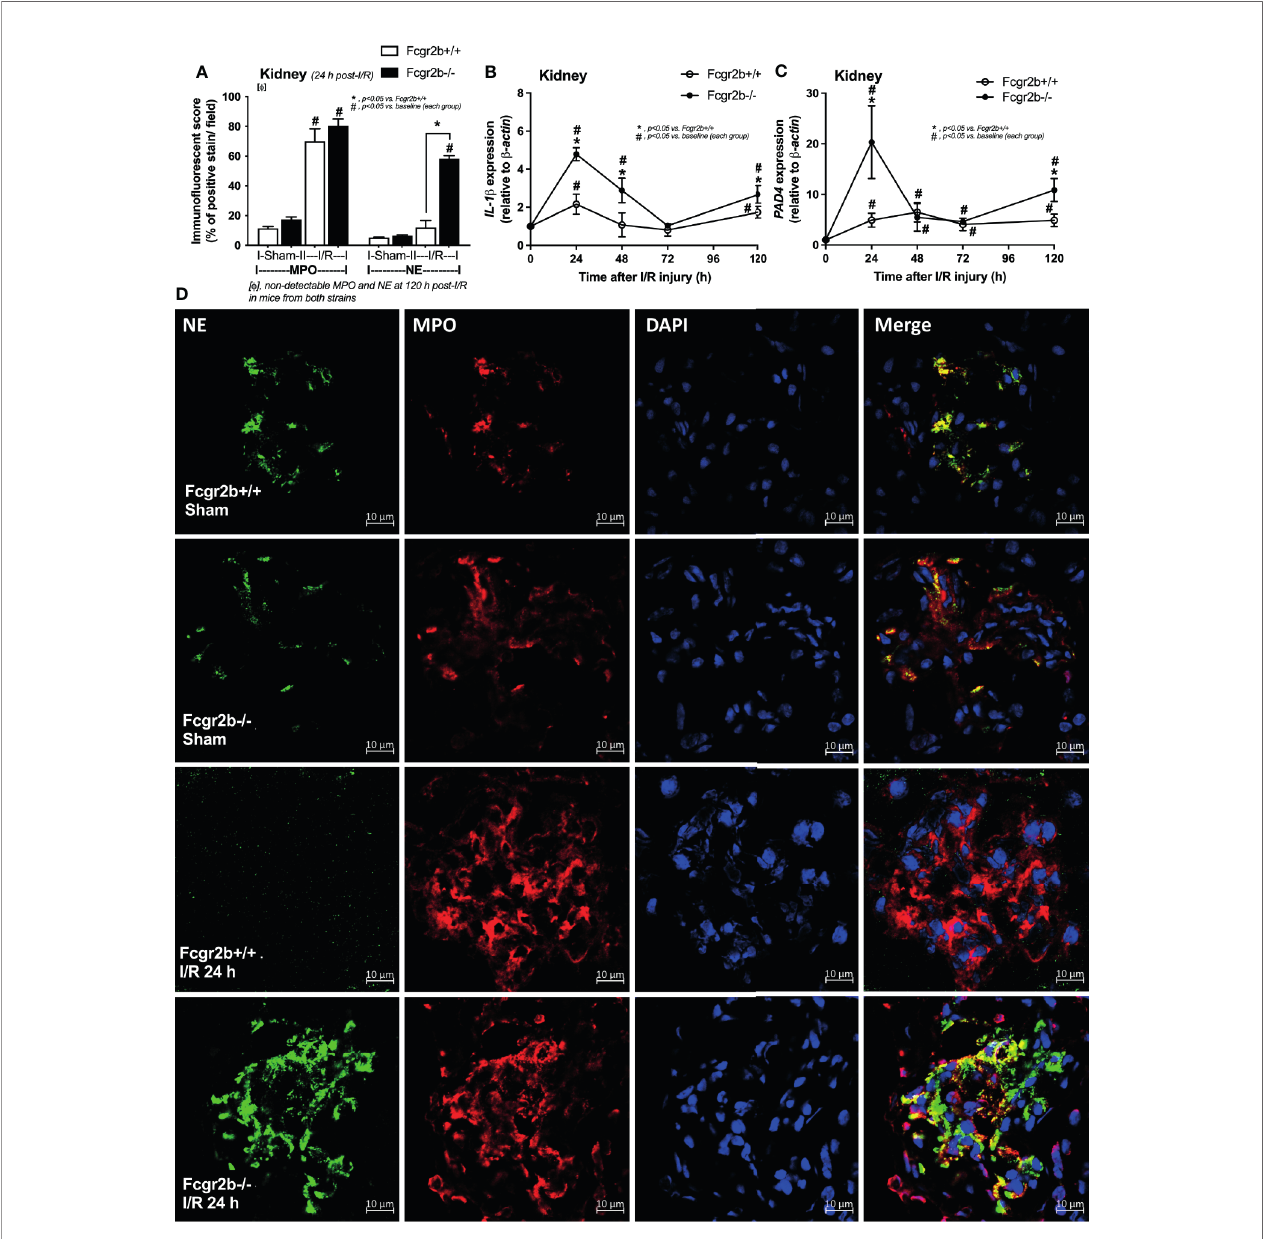
FIGURE 3 | Renal ischemia reperfusion injury (I/R) at 24 h induced more prominent neutrophil extracellular traps (NETs) in renal glomeruli of lupus prone mice. Characteristics of NETs in kidneys from Fcgr2b-/- or wild-type (Fcgr2b+/+) mice after renal ischemia reperfusion injury (I/R) as determined using co-detection of myeloperoxidases (MPO) and neutrophil elastase (NE) at 24 h post-I/R (A) (n = 5 – 8/group) and gene expression in the time-point of IL-1 b and PAD4 (B, C) (n = 6 – 7/ time-point) with the representative immuno fl uorescent pictures of NE (green), MPO (red) and 4 ’ ,6-diamidino-2-phenylindole (DAPI, blue nuclear staining) at 24 h post- I/R (or sham) (original magni fi cation 630x) (D) are